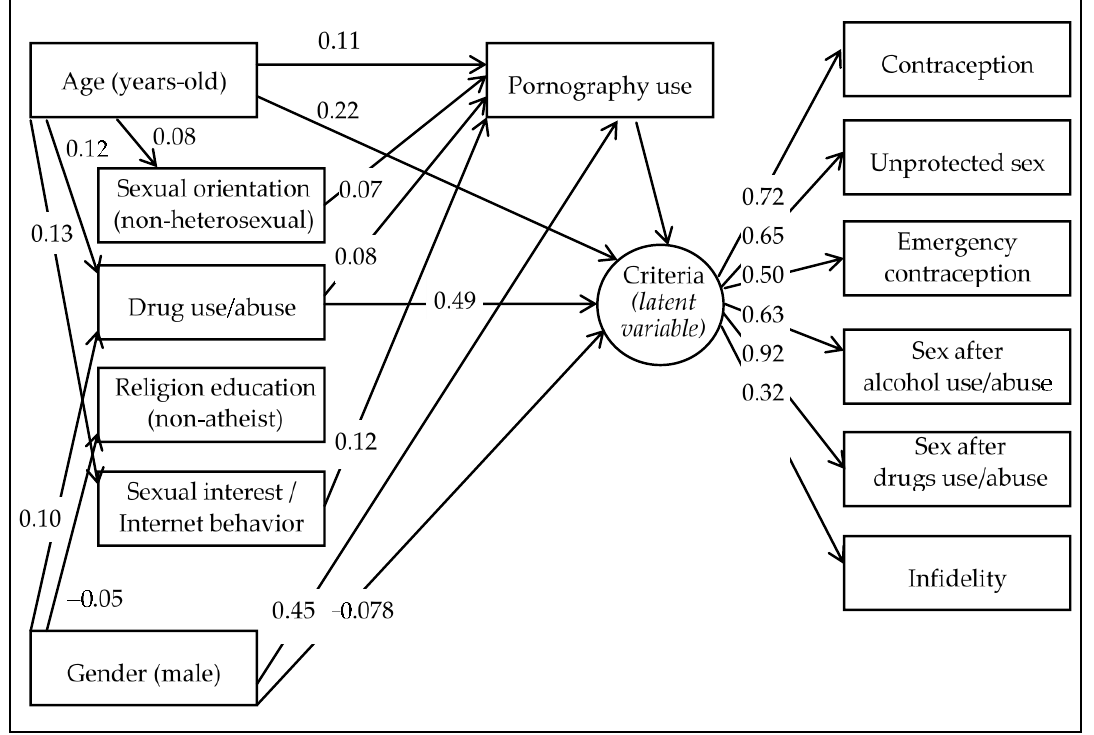
Figure 1. Path diagrams: standardized coefficients in the Structural Equation Modeling (SEM) ( n = 1500). Note: Only significant parameters were retained in the model.